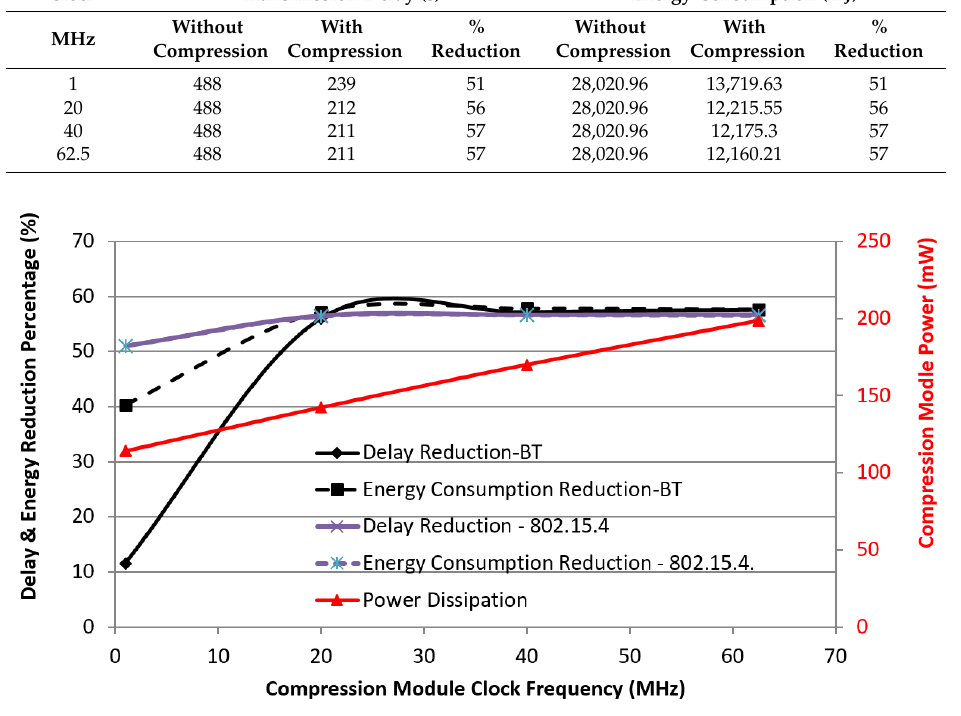
Figure 7. Compression module performance effect wrt ECG_UoP/shimmer setup.